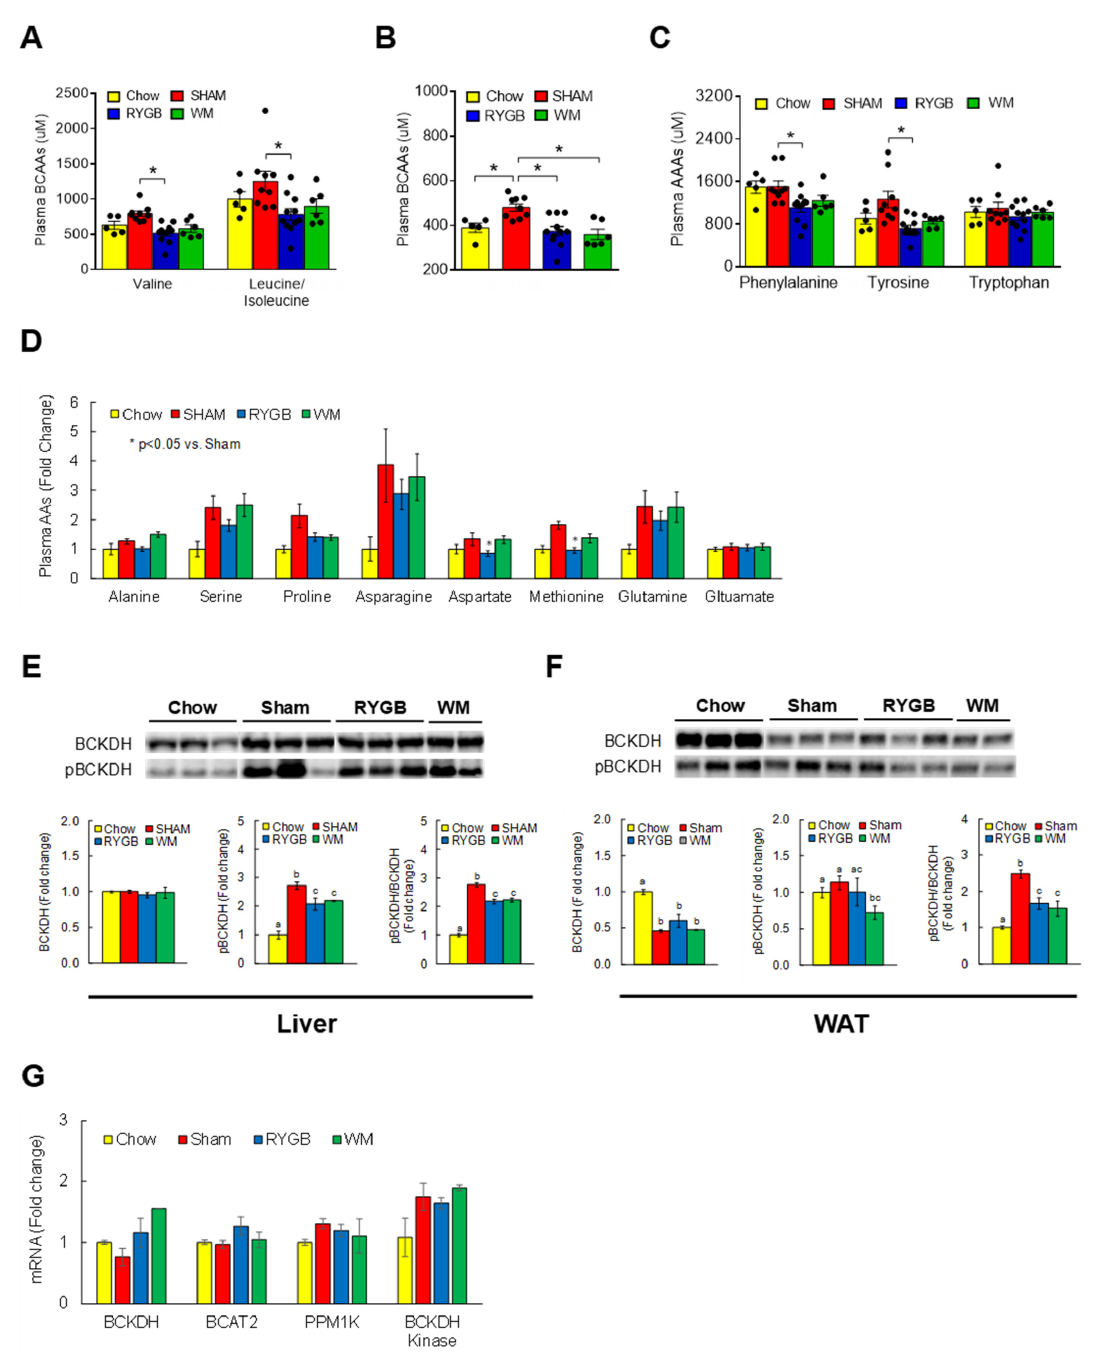
Figure 1. RYGB surgery effectively lowers circulating BCAAs that is independent of food intake. Serum amino acids collected at sacrifice were analyzed by targeted metabolomics via LC-MS. ( A ) Individual serum BCAAs. ( B ) Whole BCAA levels as measured by a separate enzymatic as- say. ( C ) Aromatic amino acids (AAAs) and ( D ) other essential and nonessential amino acids via LC-MS. ( E ) Protein expression of BCKDH, the rate-limiting enzyme in the BCAA catabolic pathway and the phosphorylated, inactive state of BCKDH, was measured by Western blots in the liver and ( F ) in epididymal white adipose tissue (WAT). The ratio of pBCKDH/BCKDH indicates the inactivity index; n = 5/group. ( G ) mRNA abundance of genes related to BCAA breakdown in the liver as assessed by RT-qPCR. Phosphatase—BCKDH phosphatase; Kinase—BCKDH kinase. Analyzed by a one-way ANOVA followed by Tukey’s post hoc test. Bars with different letters are significantly different from each other; * p <